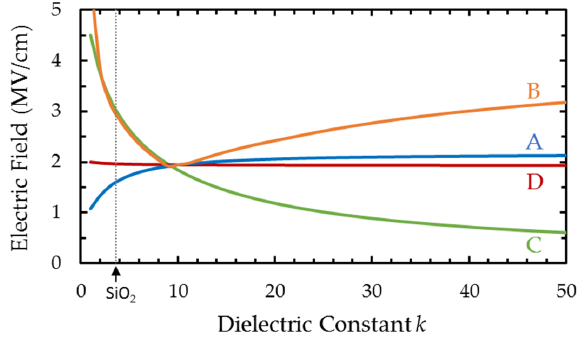
Figure 5. Maximum electric field characteristics of a diode with different k .